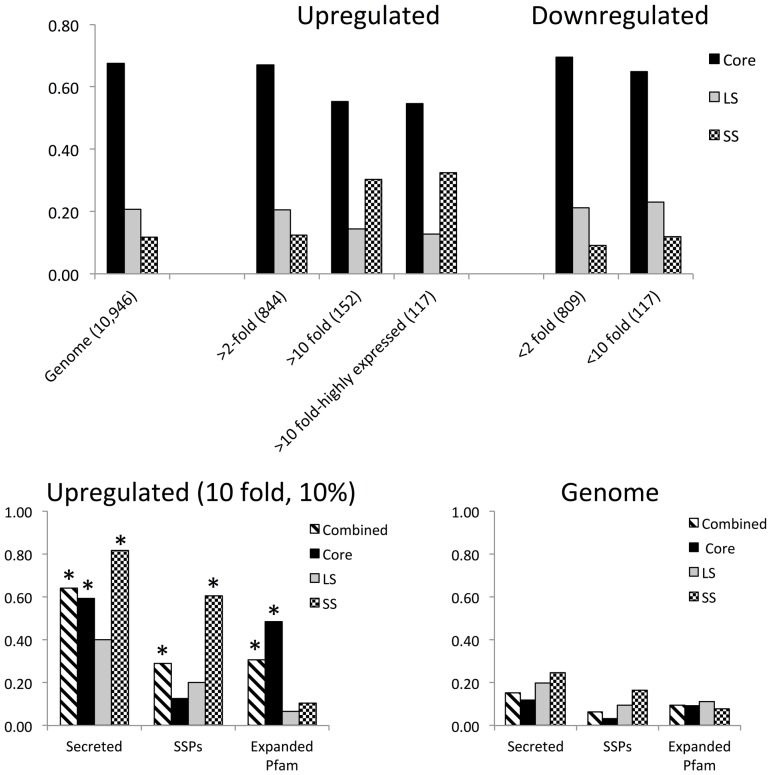
Gene expression by M. haptotylum during the infection of the nematode C. briggsae.(A) Shown is the proportion of protein-coding genes that were upregulated or down-regulated at 2-fold or 10-fold levels when comparing the expression levels in penetrating mycelium (4 hours of infection) and knobs. The genes were classified into core, lineage-specific (LS) and species-specific (SS) genes. (B) Features of the highly upregulated (>10 fold) and expressed (>10%) genes. “*” indicates the categories of genes that were significantly (P<0.001) enriched among the upregulated genes (left) as compared with their distribution in the genome (right). “Combined” includes core + LS + SS.